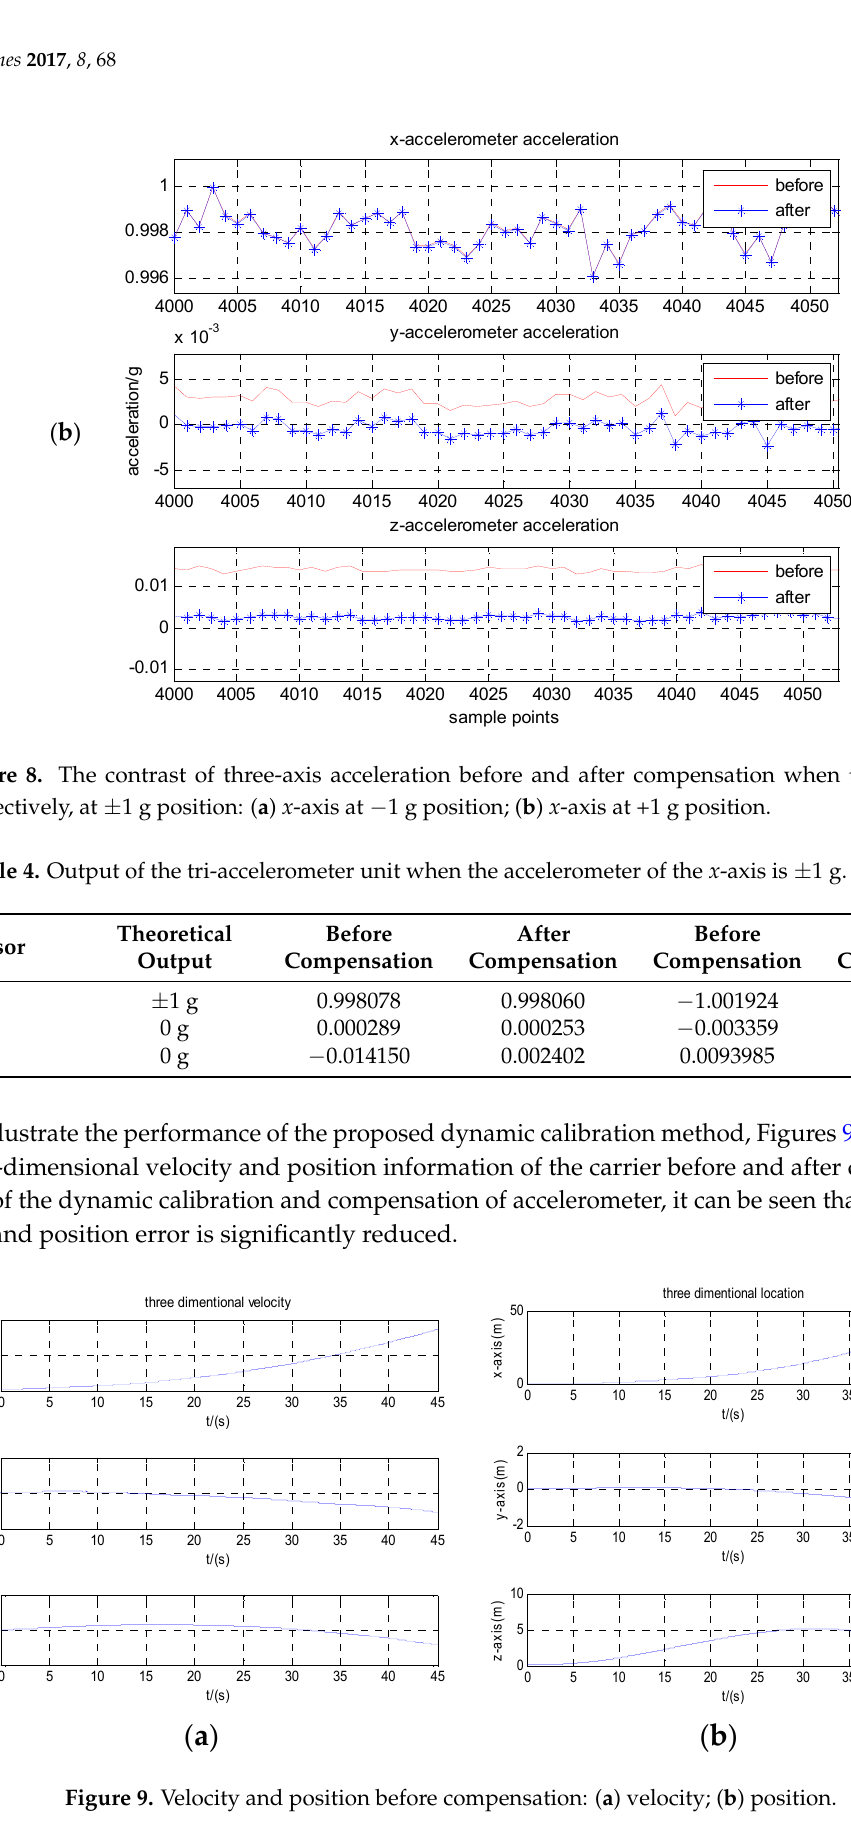
Figure 9. Velocity and position before compensation: ( a ) velocity; ( b ) position.